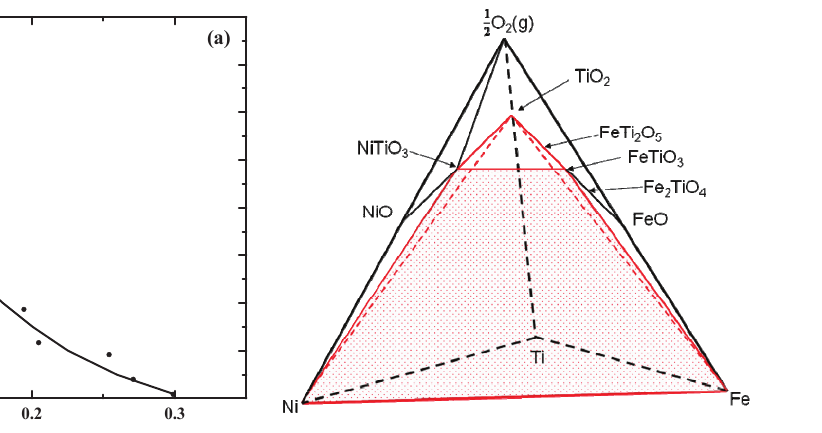
Figure 3. Isothermal section in the quaternary system Fe- Ni-Ti-O showing phase relations of the interest to reactive interdiffusion in the couple Fe: NiTiO 3